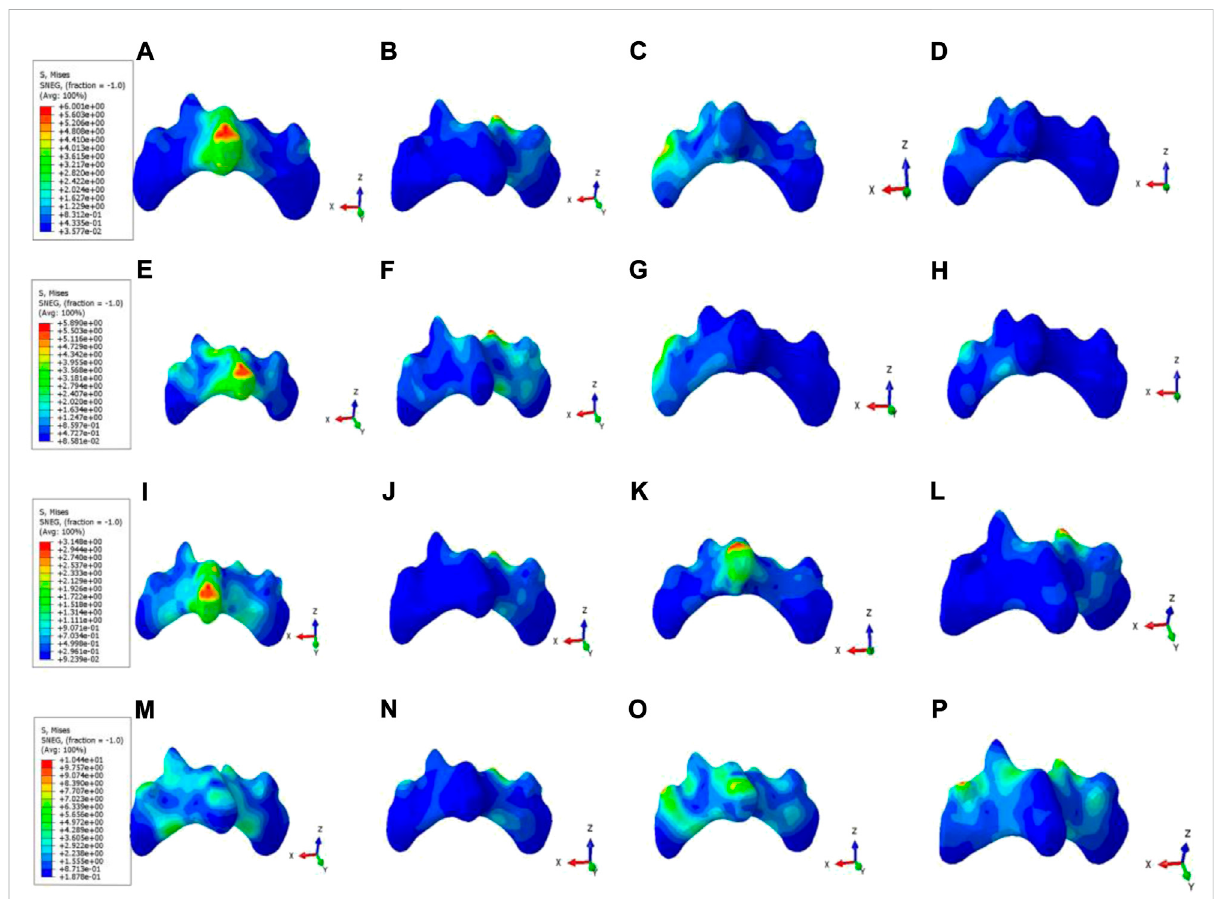
FIGURE 8 Stress nephograms of pars interarticularis in Model B, C, D, and E under six motion states. (A – D) The stress distribution of Model B ’ s pars interarticularis under fl exion, extension, LAR, and LLB, respectively. (E – H) The stress distribution of Model C ’ s pars interarticularis under fl exion, extension, LAR, and LLB, respectively. (I – L) The stress distribution of Model D ’ s pars interarticularis under fl exion, extension, LAR, and LLB, respectively. (M – P) The stress distribution of Model E ’ s pars interarticularis under fl exion, extension, LAR, RAR, LLB, and RLB,